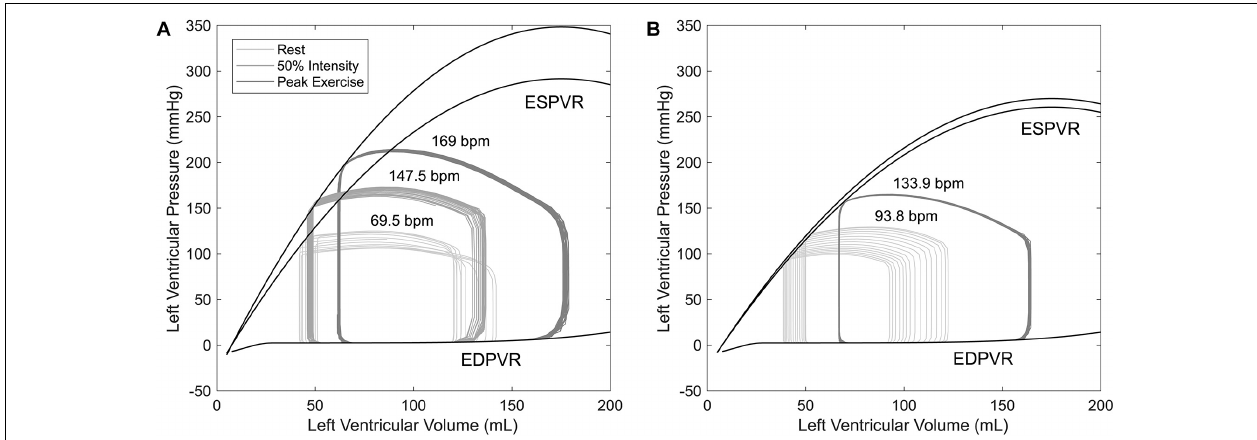
FIGURE 5 | Pressure–volume loops for a time period of 10 s obtained from simulations of healthy controls (A) and HTxRs (B) , for rest (0%), medium (50%), and peak (100%) exercise intensity. Note that peak exercise in HTxRs corresponds to 50% of exercise intensity in healthy